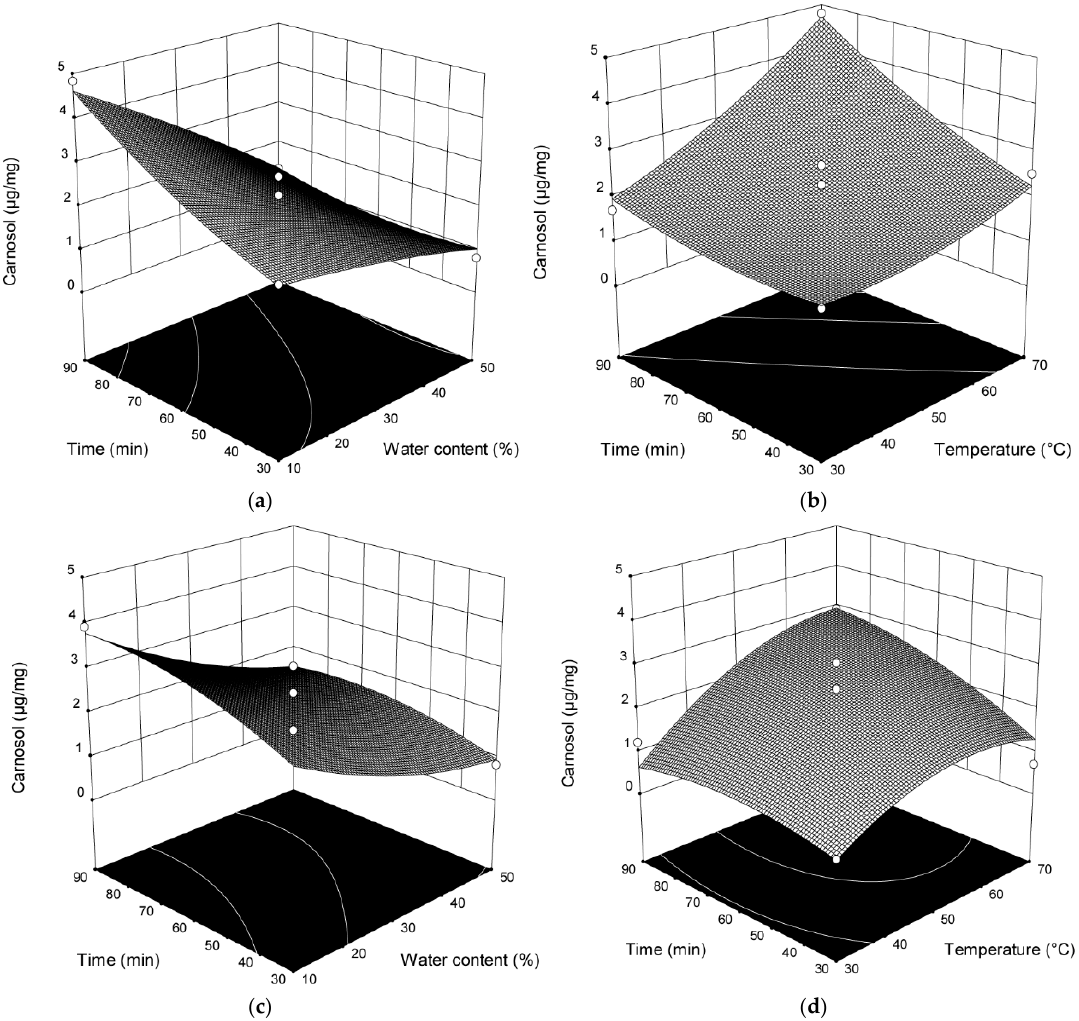
Figure 2. Three-dimensional plots for obtained content of carnosol as a function of the extraction time, temperature, and H 2 O content in the extraction with mixing and heating ( a , b ) and MCE ( c , d ). The data describing the optimal conditions for the extraction of carnosic acid and